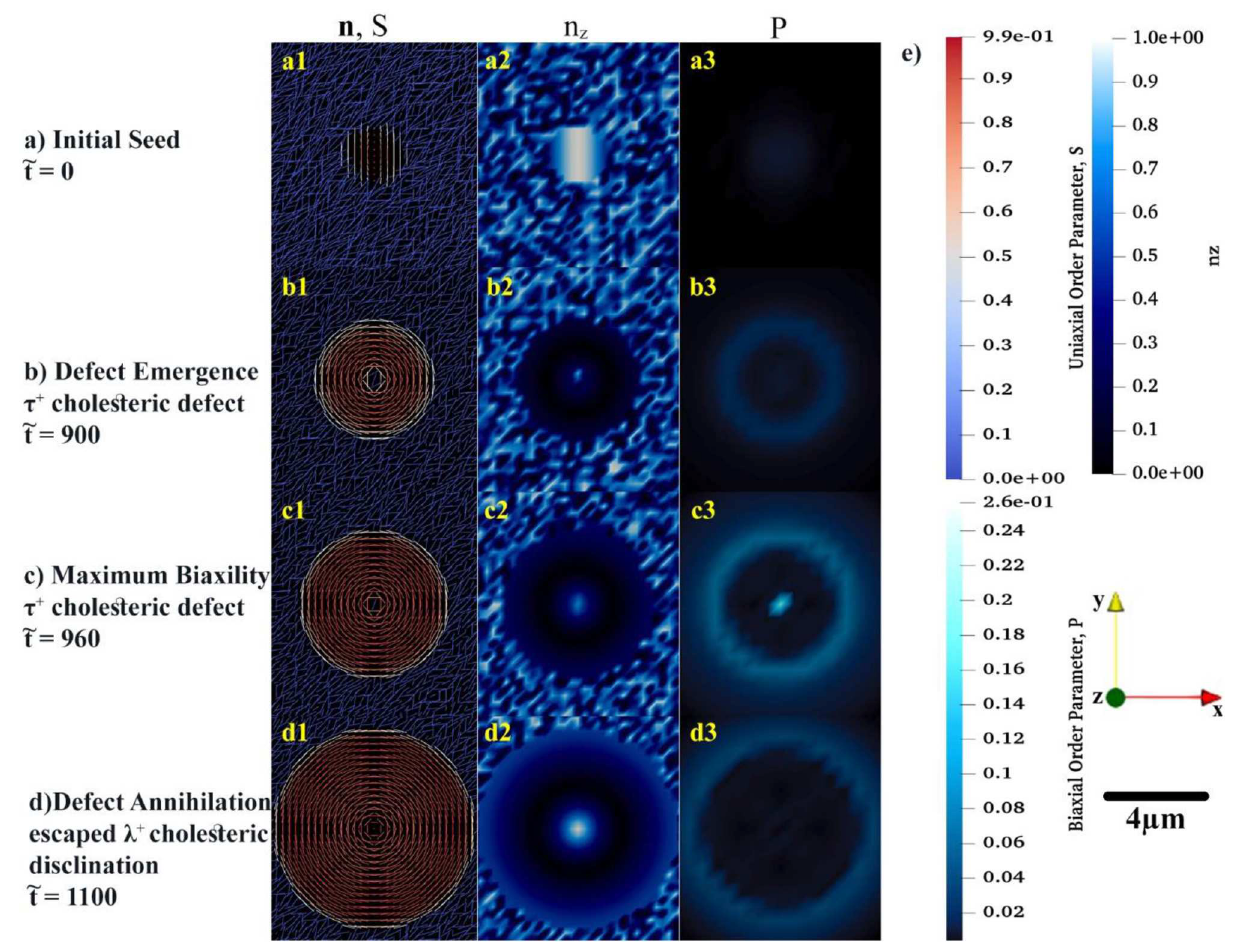
FIGURE 3 | The spatial distributions of order parameters, S and P, in conjunction with the director configuration at the early growth of cholesteric tactoid shown in (a–d) . In the first column, the uniaxial configuration, n , of tropocollagen macromolecules are represented by rods whose color (blue to red) shows the uniaxial order parameter, S. To complete the understanding about the configuration of rods in xy-plane, in the second column, the z component of n is shown by use of a monochromatic blue spectrum. In last column, the monochromatic cyan denotes the variation of biaxial order parameter during the time evolution. (e) Illustrating the color bars for S, n z, and P, the used coordination of system and length-scale